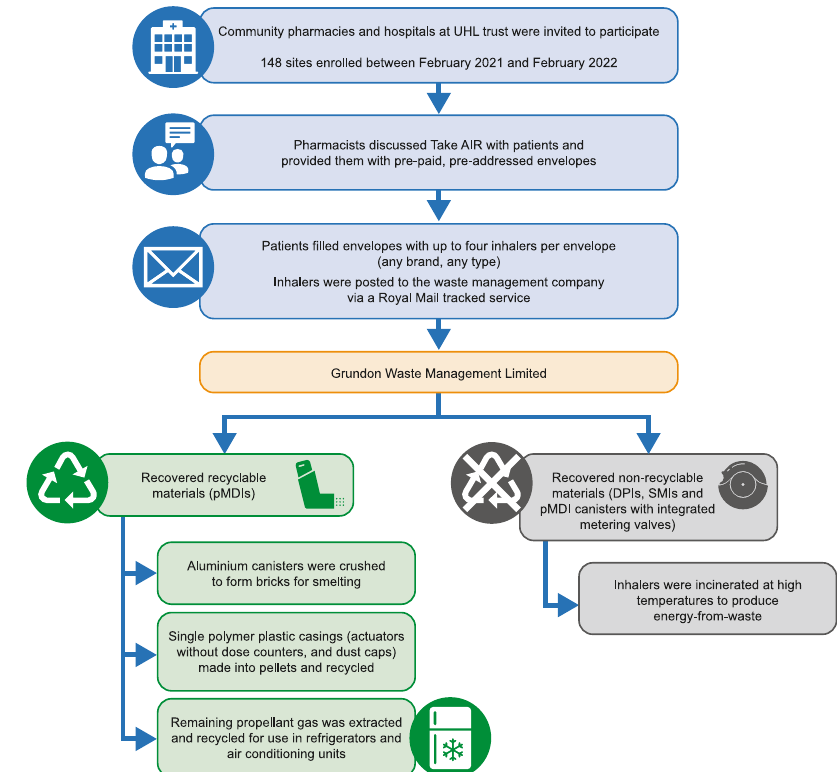
Fig. 1 The Take AIR Scheme: study design and recycling process. AIR action for inhaler recycling; DPIs dry-powder inhalers; pMDIs pressurised metered-dose inhalers; SMIs soft-mist inhalers; UHL University Hospitals of Leicester (Leicester General Hospital, Glen fi eld Hospital, Leicester Royal In fi rmary).